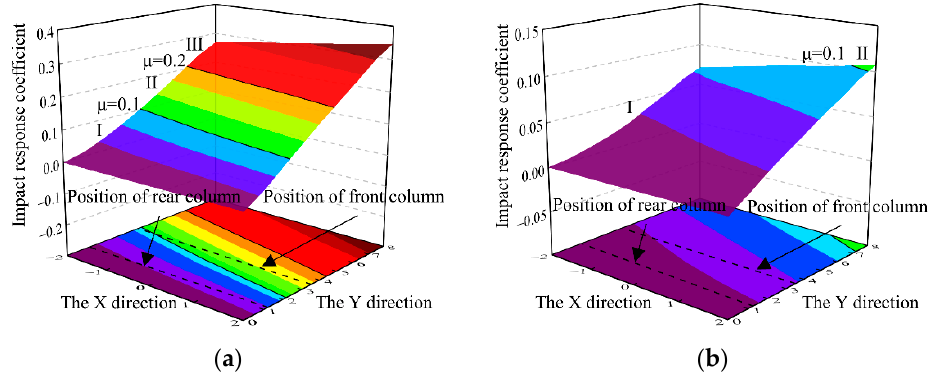
Figure 5. ( a ) Impact response coefficient of the hinge point of the front column. ( b ) Impact response coefficient of the hinge point of the rear column.